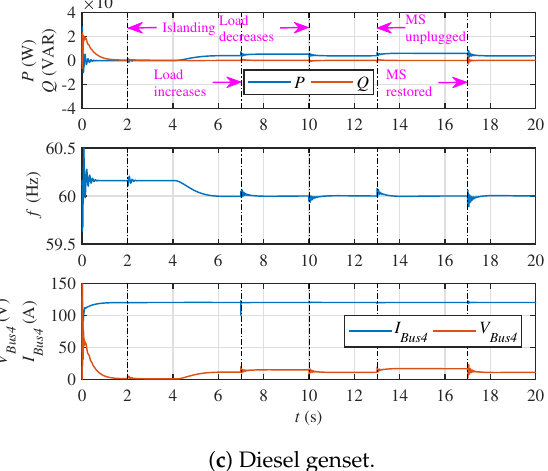
Figure 9. Performance of DG units under the proposed